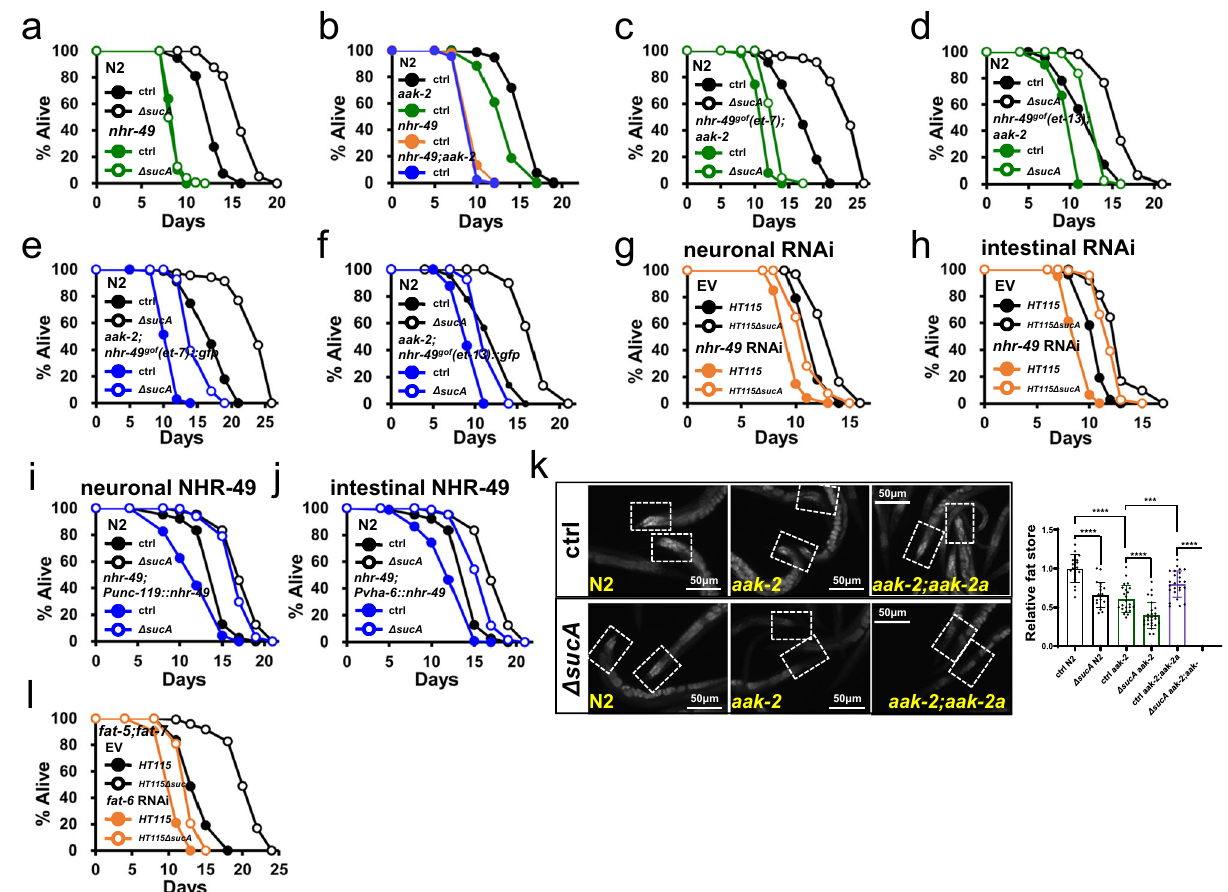
Fig. 6 | NHR-49 is required for GR-induced longevity. a Lifespan showing that NHR-49isrequiredforGR-inducedlongevity. nhr-49(nr2041) completelyabolished GR-induced longevity ( P =1, P value determined by two-tailed Student ’ s t test). Results from one of three independent experiments are shown. b Lifespans showing thatthe effects of aak-2 and nhr-49 mutation on lifespan are not additive. The mean lifespan of nhr-49;aak-2 is comparable to that of nhr-49 animals ( P =1, P value determined by two-tailed Student ’ s t test). Results from one of three biolo- gicalindependent experimentsare shown. c , d Lifespansshowing that nhr-49 gain- of-function( gof )mutations, et7 ( c )and et13 ( d ),in aak-2(ok524) animalsgaintheGR- mediated longevity ( P <1.0×10 − 10 , P value determined by two-tailed Student ’ s t test). Results from one of three biological independent experiments are shown. e , f Lifespans showing that nhr-49 gof transgenes, et7 ( e ) and et13 ( f ), rescued GR inducedlongevityin aak-2 mutants( P <1.0×10 − 10 , P valuedeterminedbytwo-tailed Student ’ s t test). Results from representative experiments are shown with addi- tional repeats. g , h Lifespans showing that neither neuronal nor intestinal nhr-49 RNAi reduced the lifespan extension by GR diets ( P <1.0×10 − 10 , Student ’ s t test). Tissue-speci fi cRNAianimalsareusedforneuronal nhr-49 RNAiknockdown( g )and